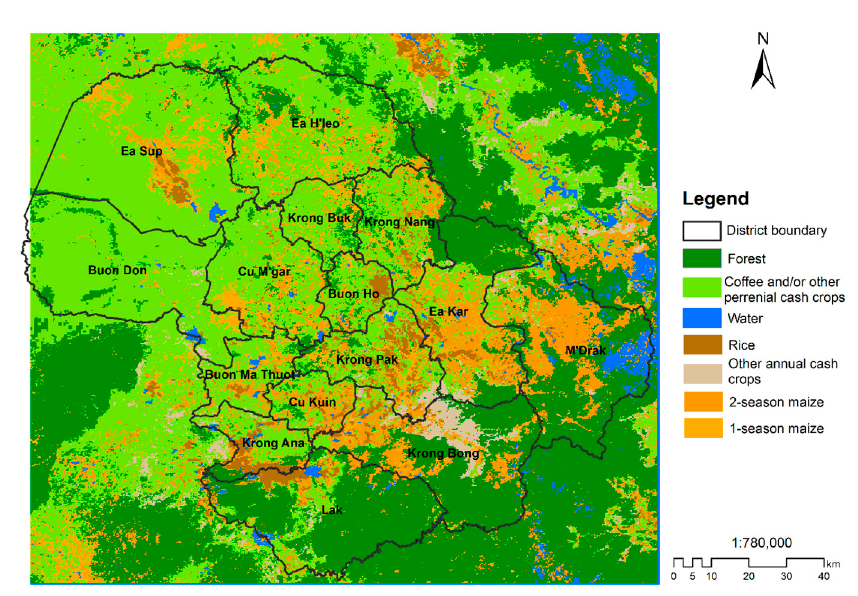
Figure 8. Distribution of maize cropping patterns and other vegetation cover types using ENVI Support Vector Machine classifier.